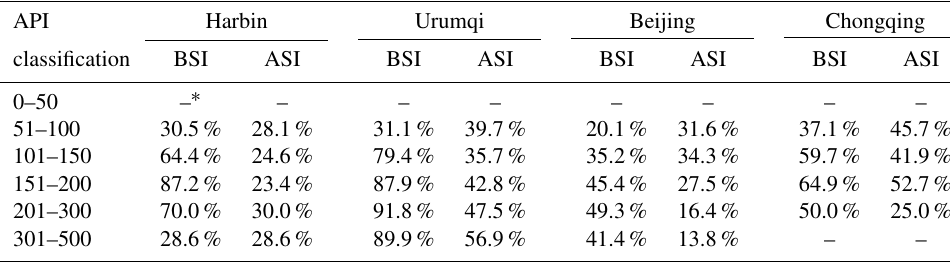
Table 2. How many days are identified as air stagnation days in each API category?